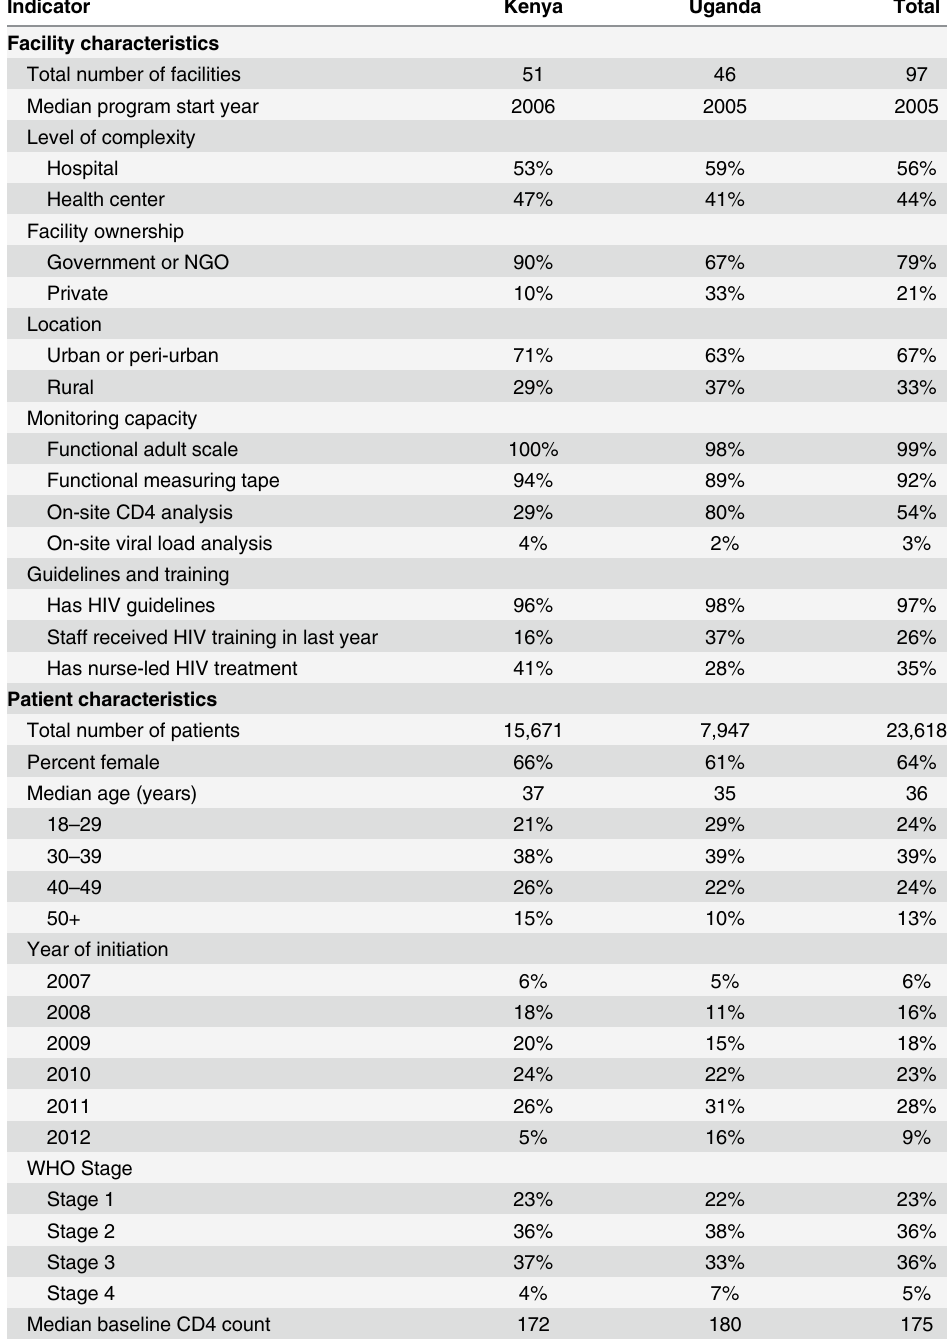
Table 1. Characteristics of sampled facilities and patients at